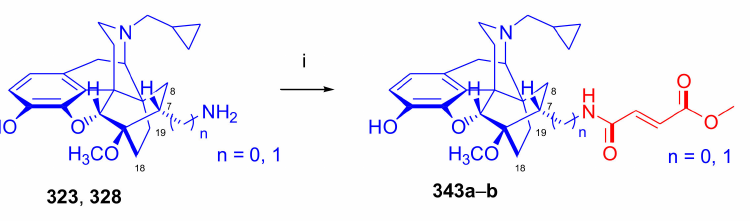
Figure 88. Synthesis of 7 α -fumaroylamino-6,14-ethenomorphinan analogues. Reagents and conditions : (i): MeO 2 CCH=CHCOCl, Et 3 N, CH 2 Cl 2 , under nitrogen, 1 h, 343a , 65%, 343b ,